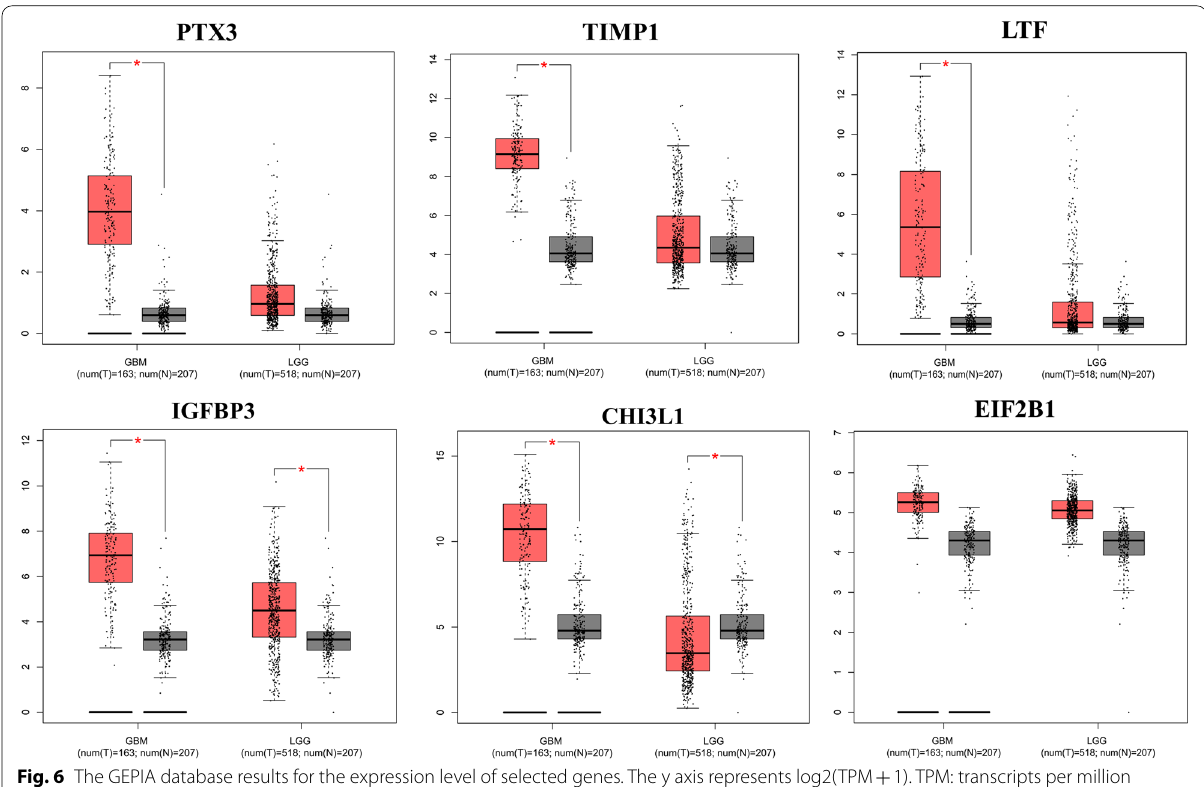
Fig. 6 The GEPIA database results for the expression level of selected genes. The y axis represents log2(TPM